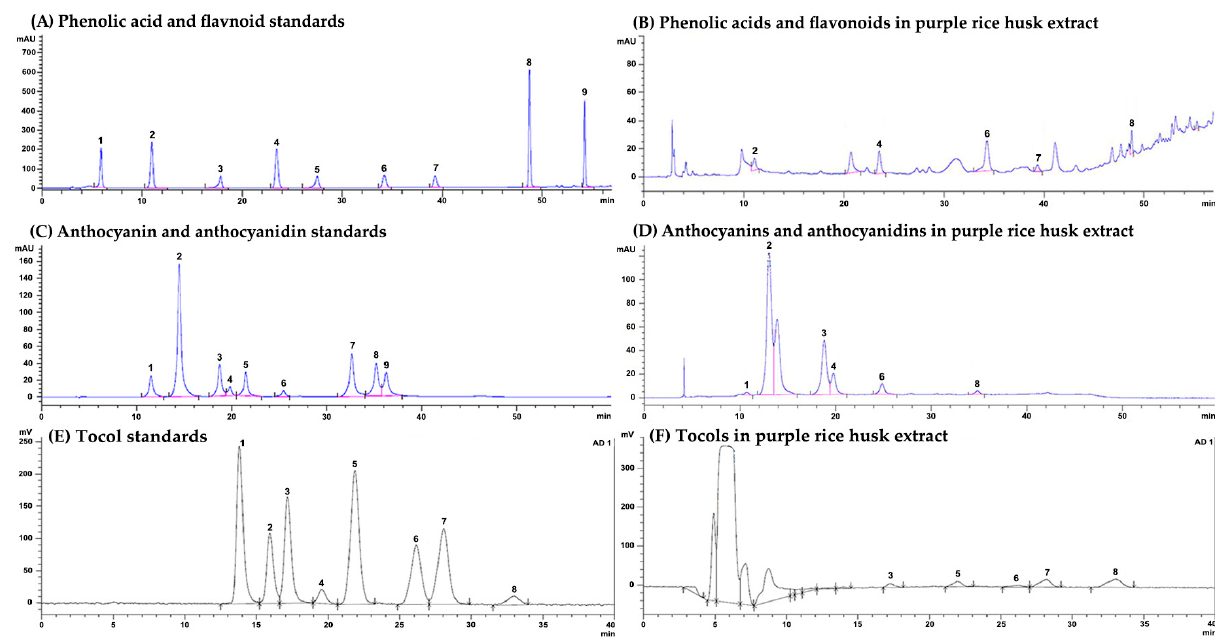
Figure 1. The HPLC chromatograms of ( A ) a mixture of phenolic acid and flavonoid standards: peaks 1, gallic acid; 2, protocatechuic acid; 3, catechin; 4, vanillic acid; 5, epicatechin; 6, p -coumaric acid; 7, ferulic acid; 8, rutin; and 9, quercetin, ( B ) phenolic acids and flavonoids in purple rice husk extract, ( C ) anthocyanin and anthocyanidin standards. Peaks 1, delphinidin-3-glucoside; 2, cyanidin-3- O -glucoside; 3, peonidin-3- O -glucoside; 4, malvidin-3-glucoside; 5, delphinidin; 6, cyanidin; 7, pelargonidin; 8, peonidin; and 9, malvidin, ( D ) anthocyanins and anthocyanidins in purple rice husk extract, ( E ) tocol standards. Peaks 1, δ -tocotrienol; 2, β -tocotrienol; 3, γ -tocotrienol; 4, α -tocotrienol; 5, δ -tocopherol; 6, β -tocopherol; 7, γ -tocopherol; and 8, α -tocopherol, ( F ) tocols in purple rice husk